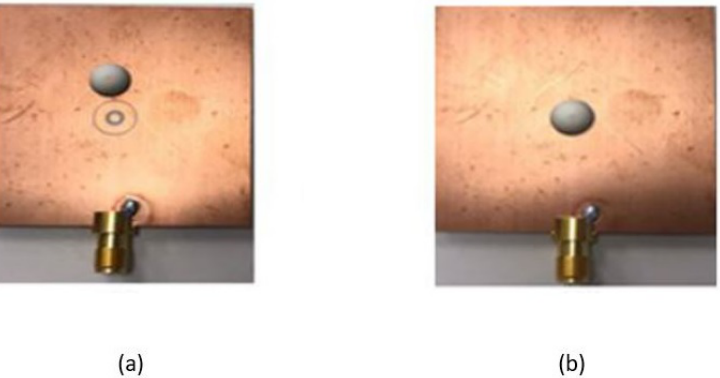
Figure 3. The prototype of a hemispherical DRA ( a ) Highlighted DRA position on the ground plane, ( b ) Assembled DRA.